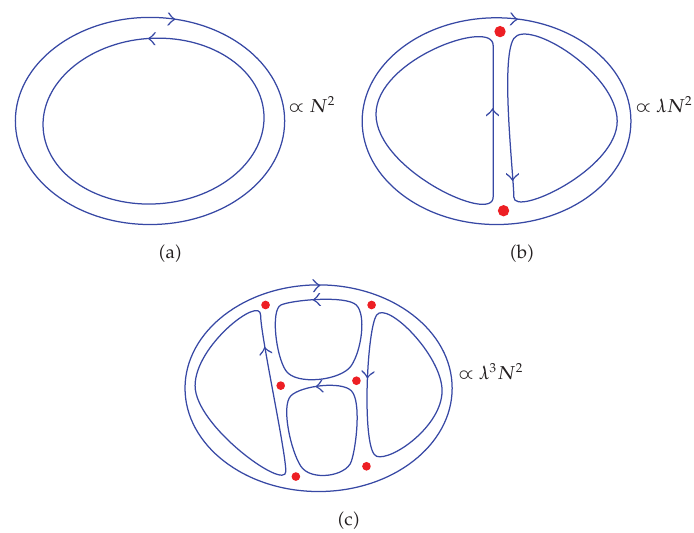
Figure 3: Planar graphs that contribute to the vacuum → vacuum